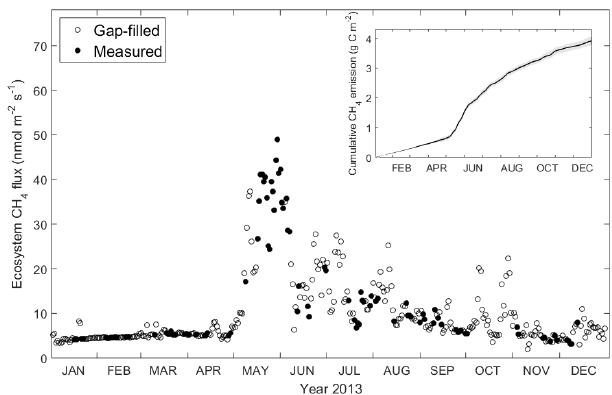
Figure 4. Daily average of ecosystem CH 4 flux measured by the EC tower and cumulative CH 4 emission in 2013. Filled dots indicate measurement (when available half-hourly measurement data ≥ 10) and circles indicate gap-filled data (when available half-hourly mea- surement data < 10). The insert shows cumulative CH 4 emission, with the error bounds in grey reflecting the 95% confidence inter- val for the gap-filling